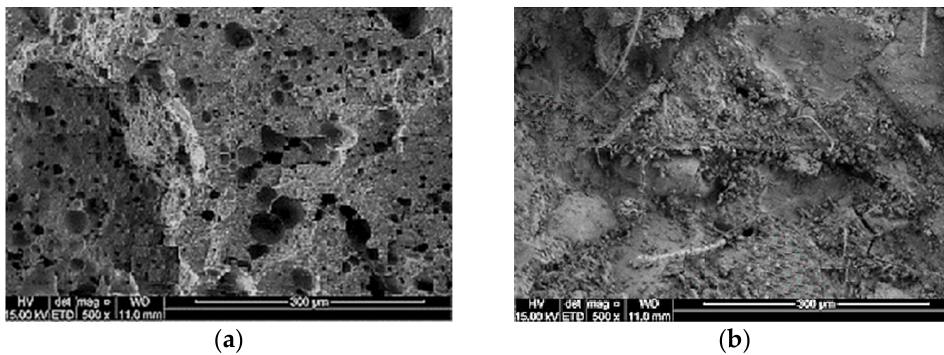
Figure 9. SEM images of LFC. ( a ) control LFC (no fiber inclusion); ( b ) LFC with the inclusion of kenaf fiber.